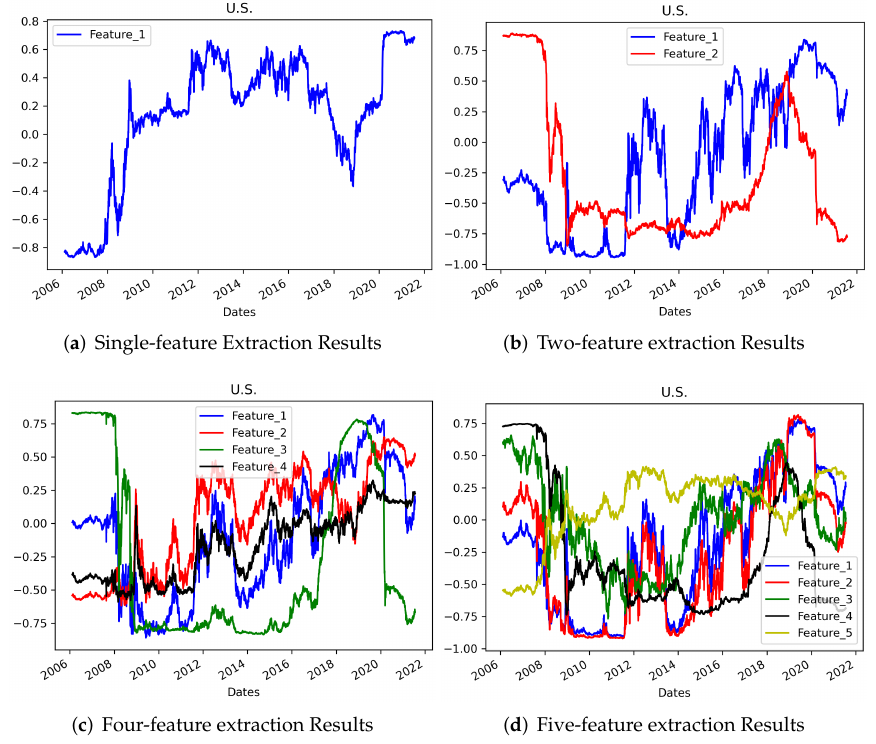
Figure 18. AE Results for the US data with different density